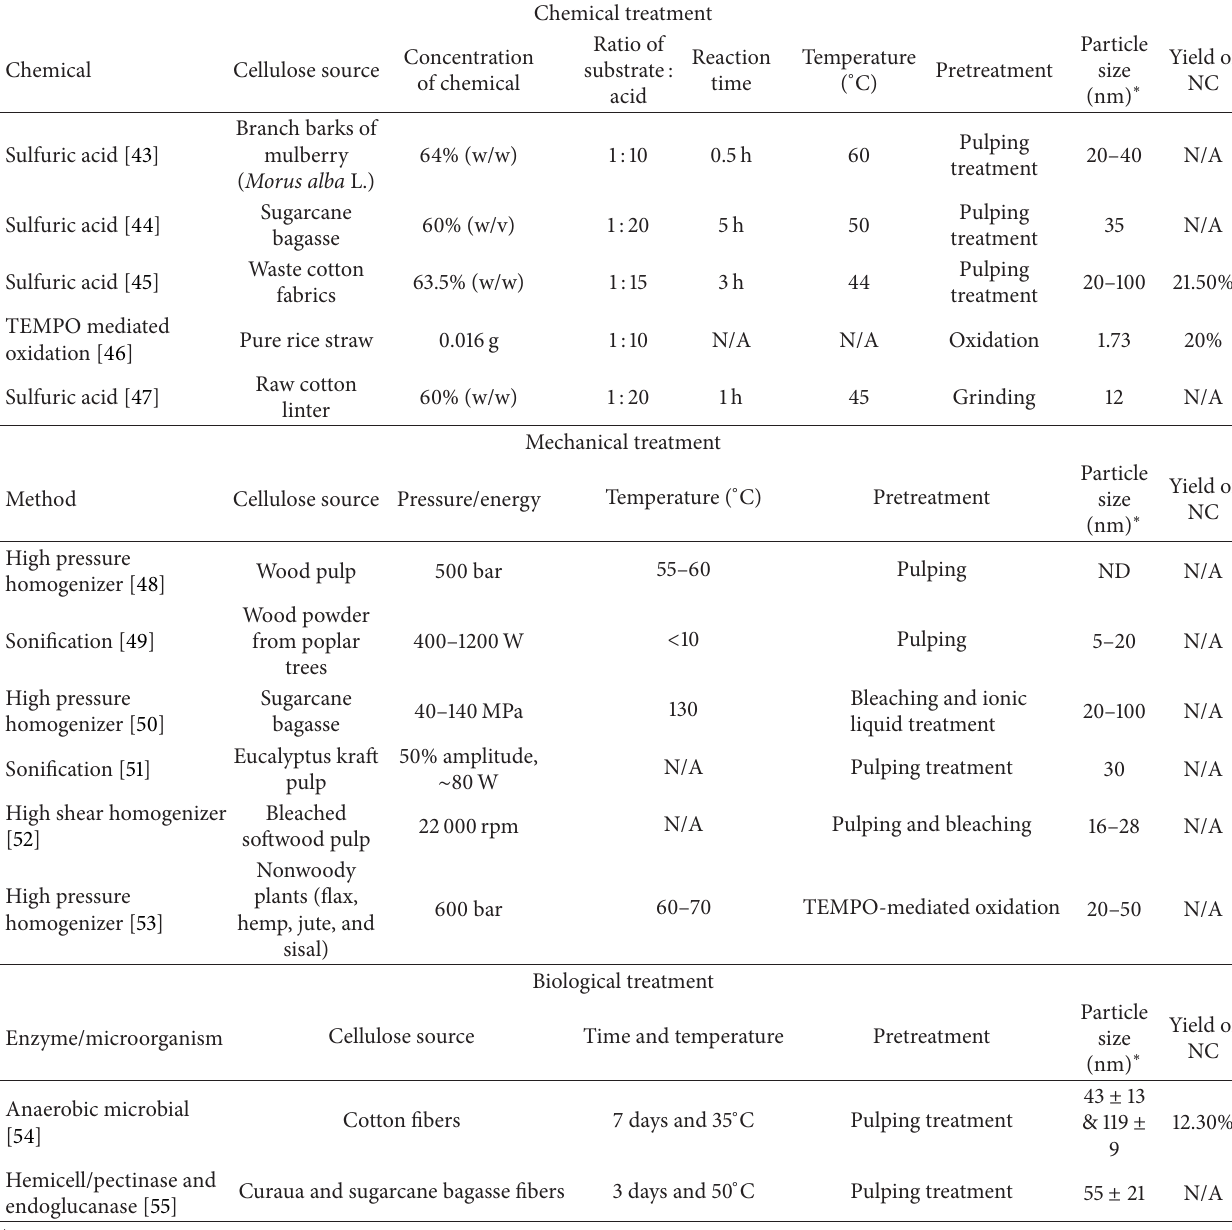
Table 4: Summary of depolymerisation treatments for nanocellulose